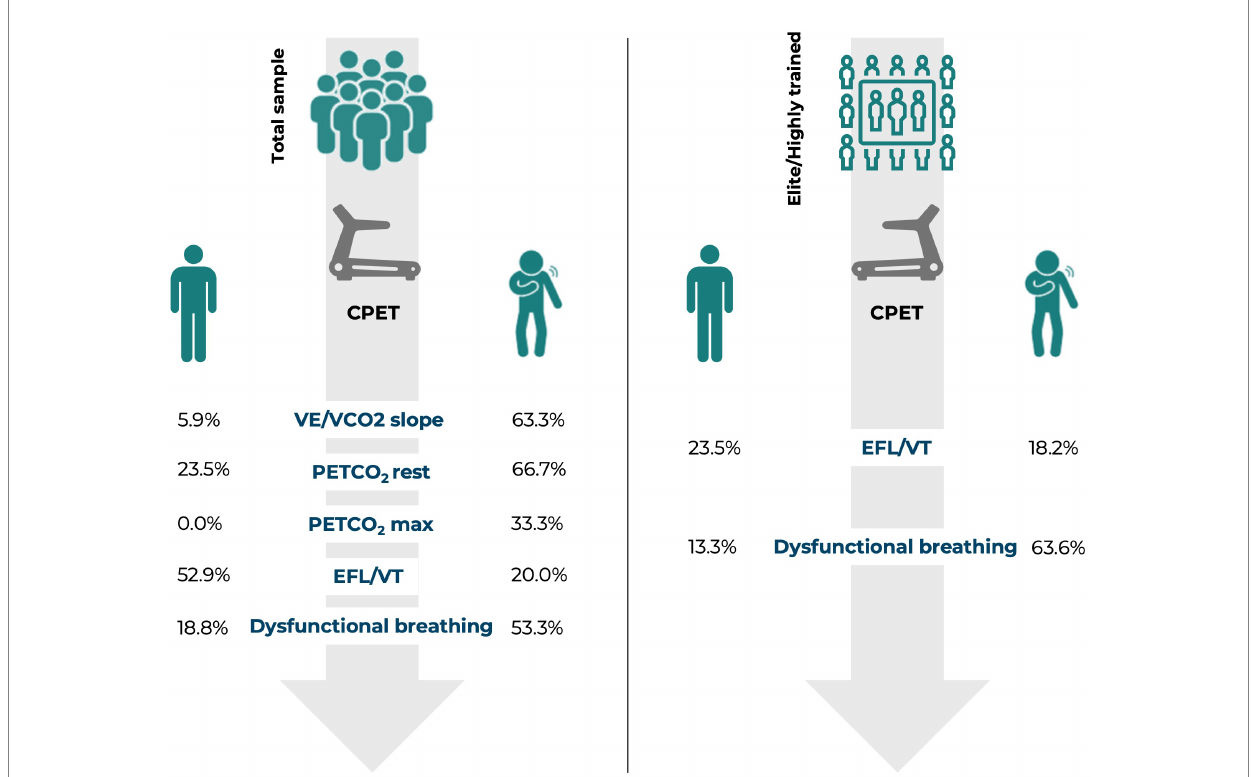
FIGURE 1 Proportion of asymptomatic vs. symptomatic participants with abnormal CPET